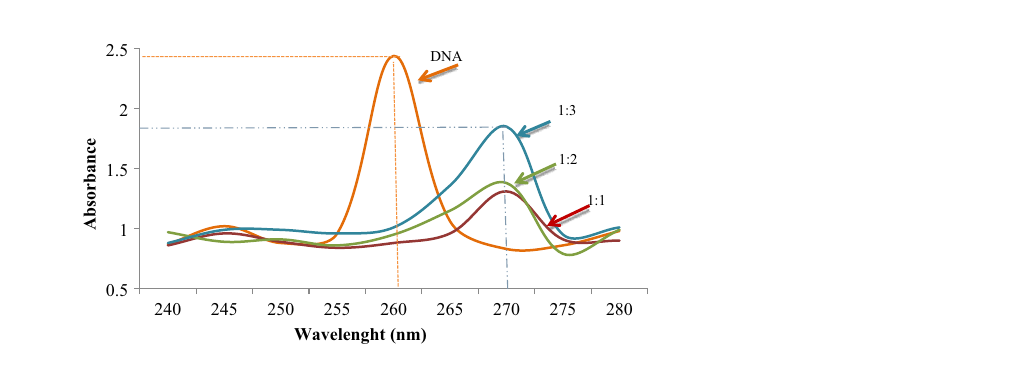
Figure 4. Spectral shift in UV spectrum of DNA after interaction with MnCl 2 . 1:1, 1:2, 1:3 show the DNA: